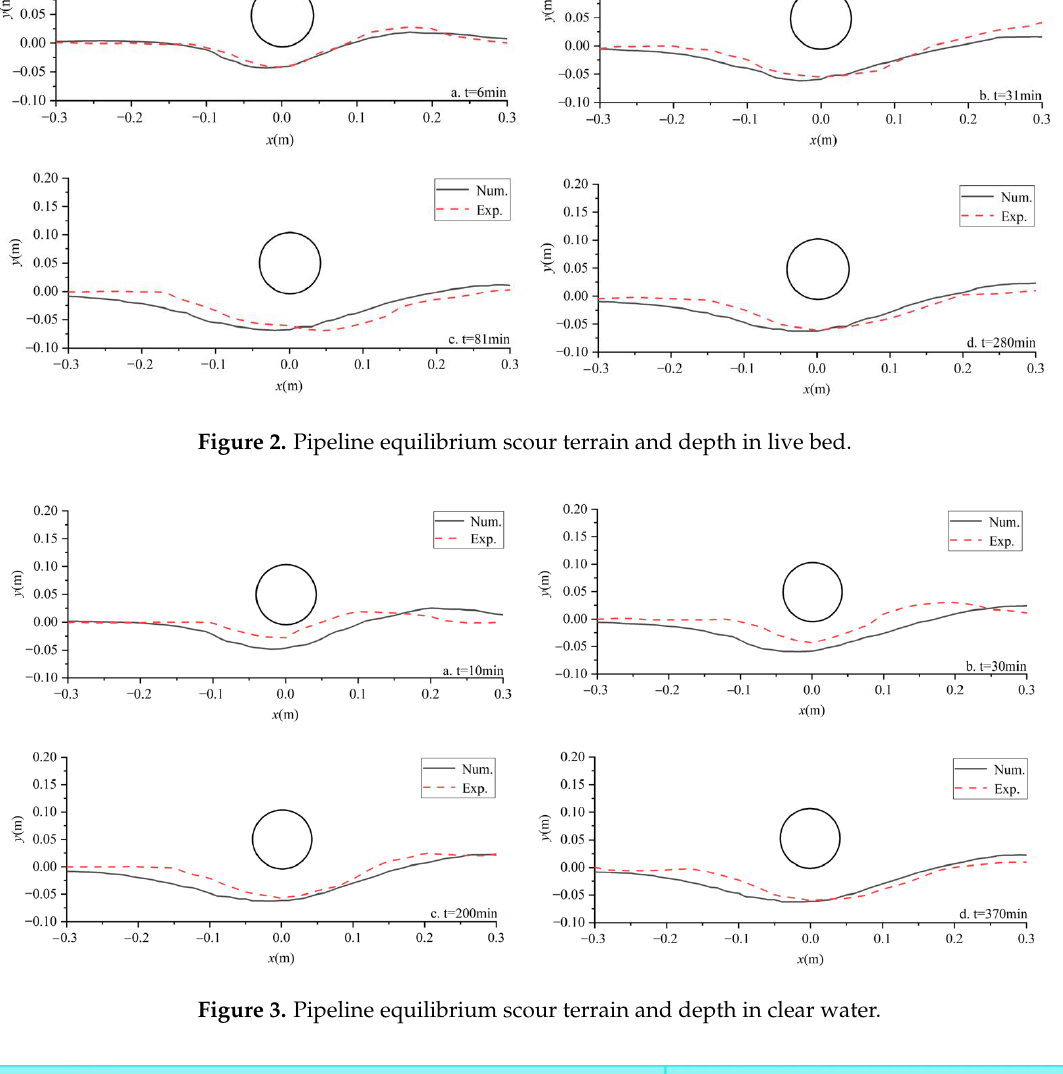
Figure 2. Pipeline equilibrium scour terrain and depth in live bed.